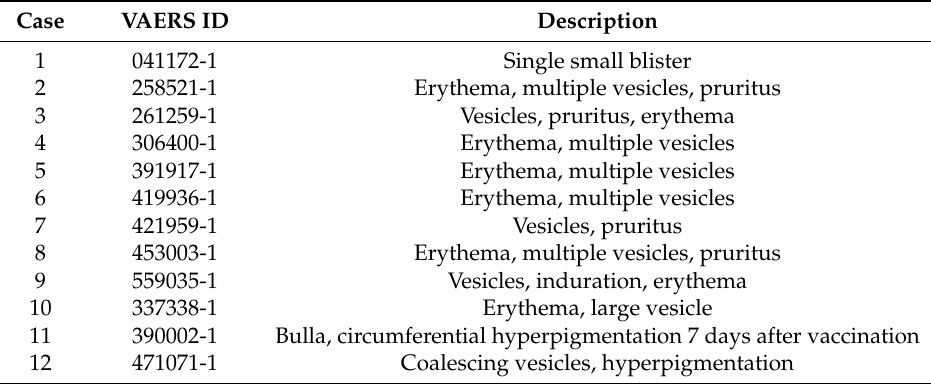
Table 1. 12 VAERS cases of local vesicular reaction to the yellow fever